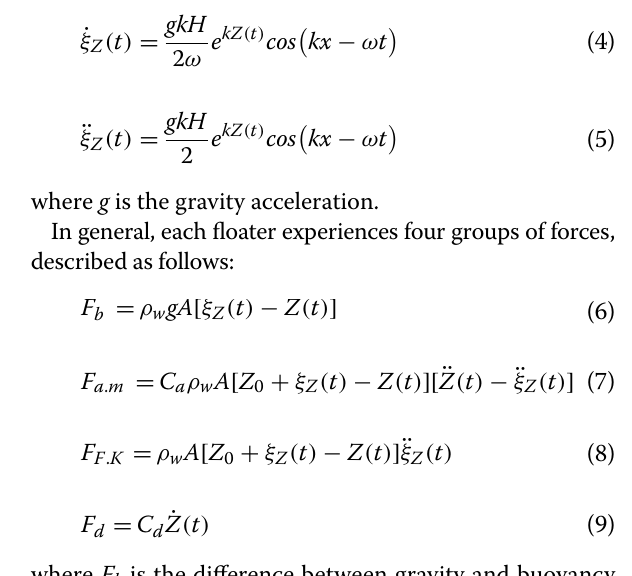
Fig. 3 A single floater facing waves. The surface wave elevation and vertical displacement of a single buoy when facing a linear wave is